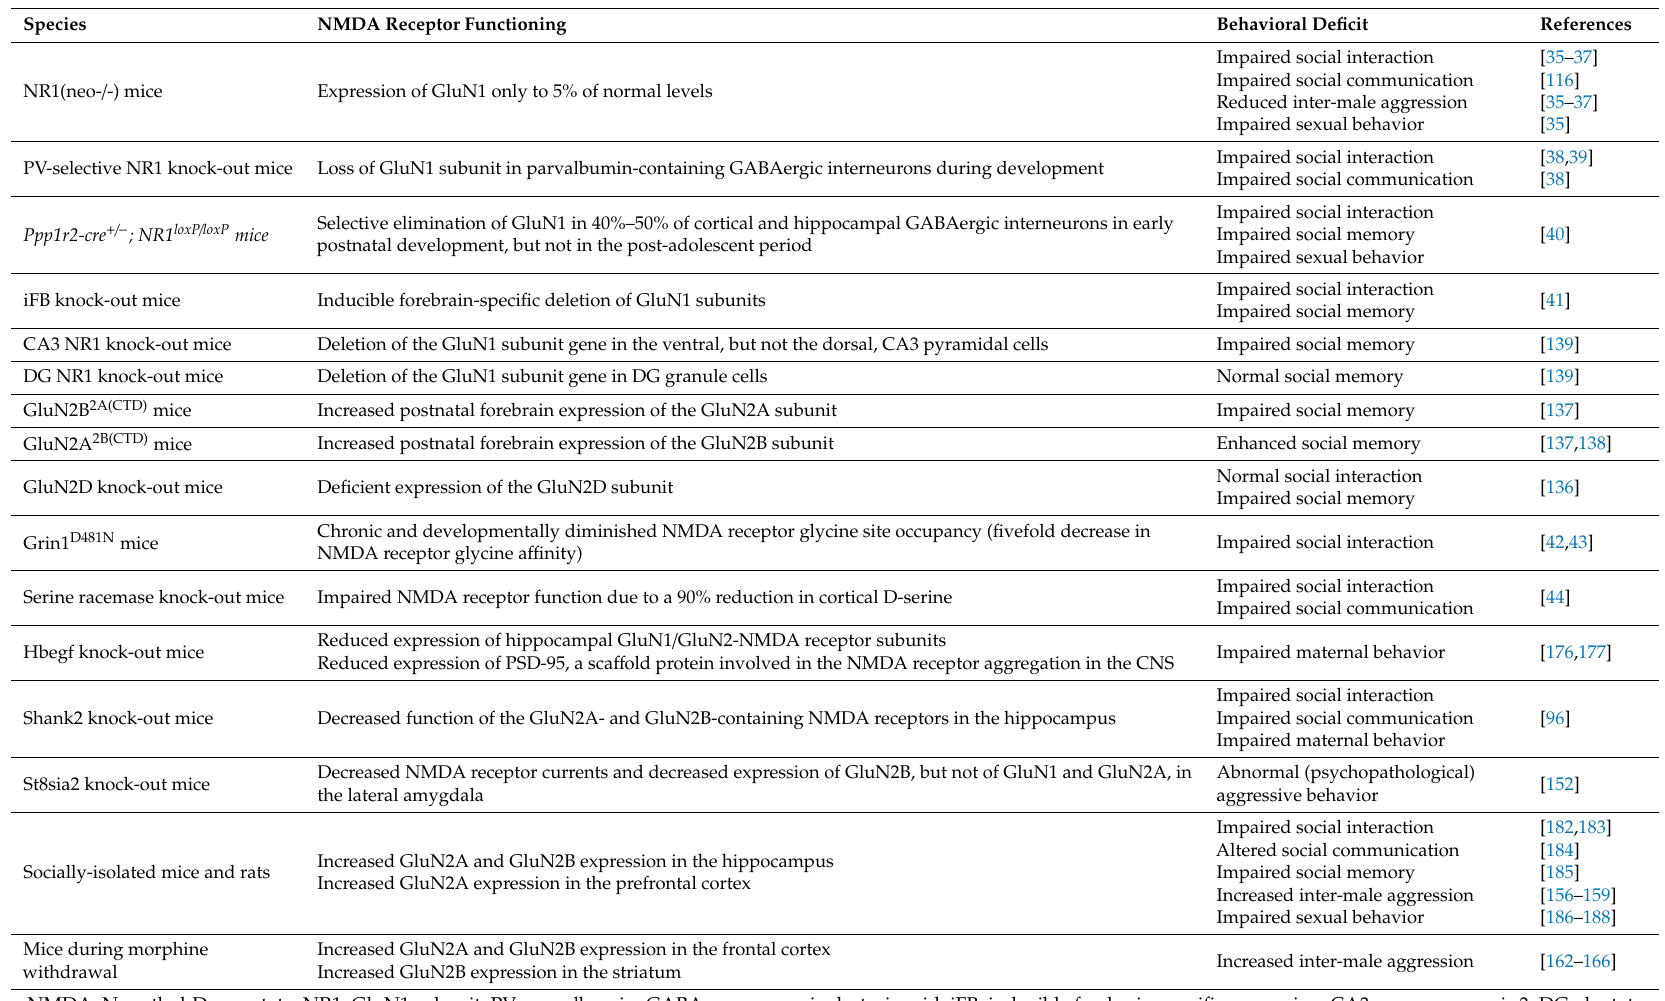
Table 1. Expression of NMDA receptors in animal models with impaired social